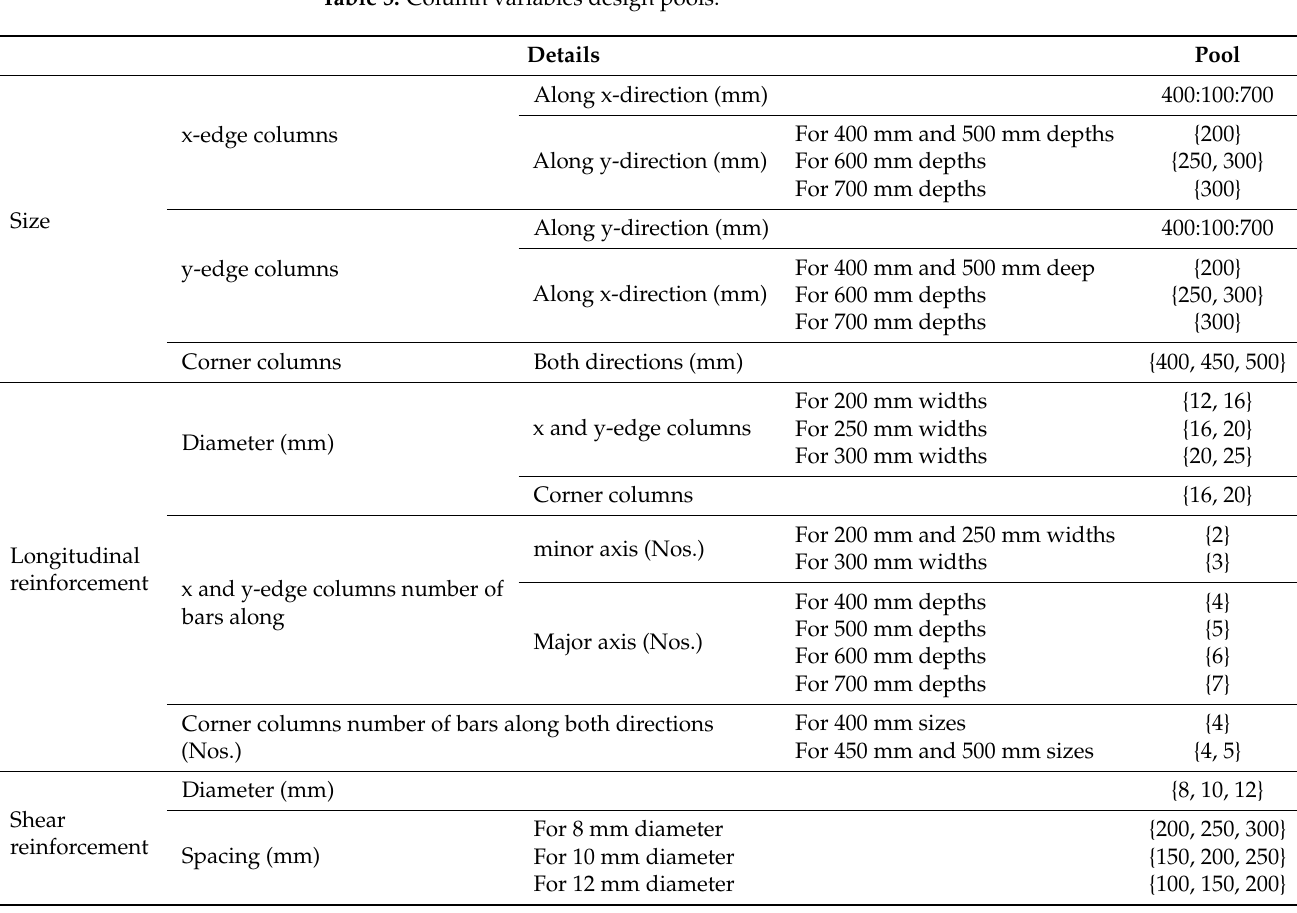
Table 5. Column variables design